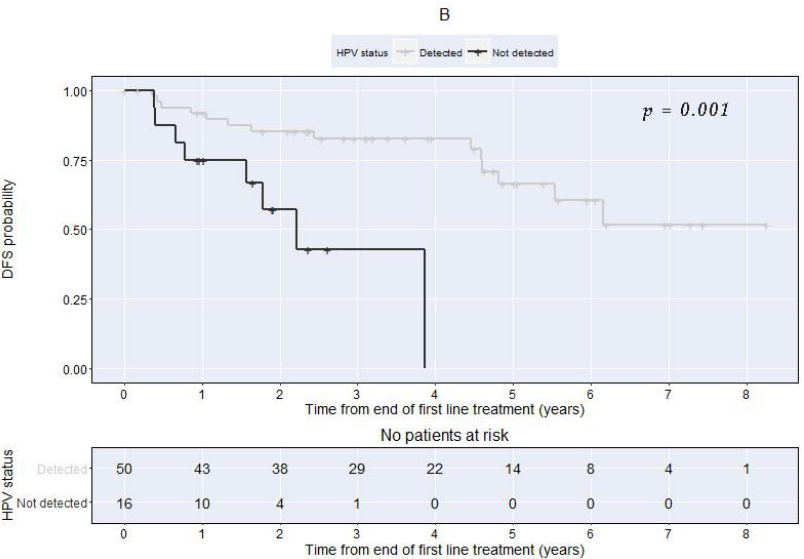
Figure 2. Kaplan–Meier curves comparing patients with detected vs. non-detected HPV at diagnosis. ( A ) Overall survival (Log-rank test chi-square = 7.3 with 1 degree of freedom, p = 0.007). ( B ) Disease-free survival (Log-rank test chi-square = 11 with 1 degree of freedom, p = 0.001). Table 4. PIK3CA mutation, HPV, and p16 status association with the overall and disease-free sur- vival by univariable analysis.